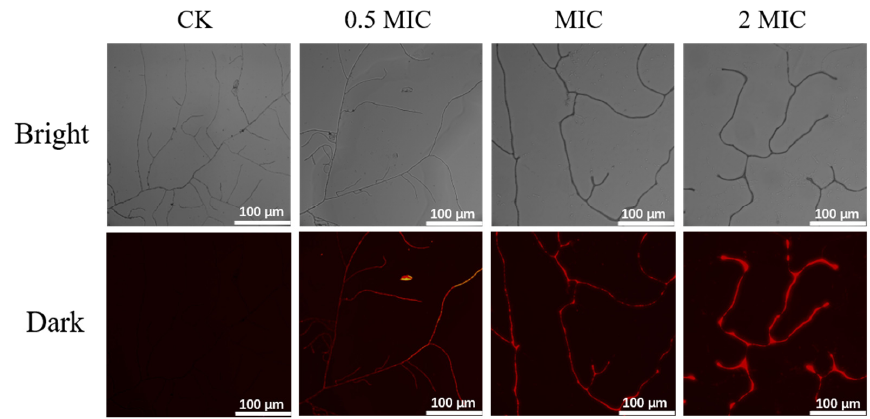
Figure 3. Mycelia morphology (in the bright field) and the corresponding PI staining im- ages (in the dark field) of P. italicum treated with different concentrations of a PCT nanoemulsion. Scale bar, 100 μ m. 100 µ